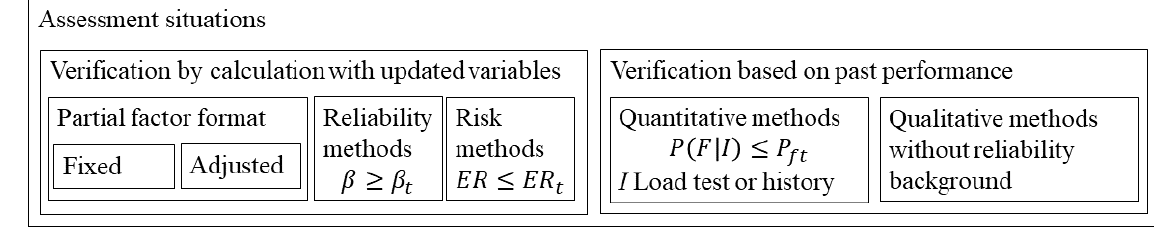
Figure 1. Quantitative and qualitative methods to verify the reliability of existing